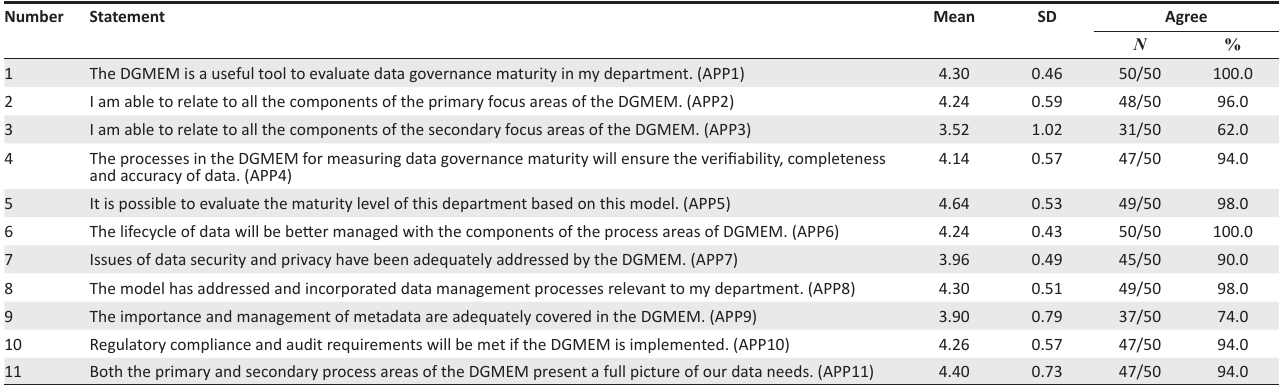
TABLE 3: Applicability of the Data Governance Maturity Evaluation Model ( N =